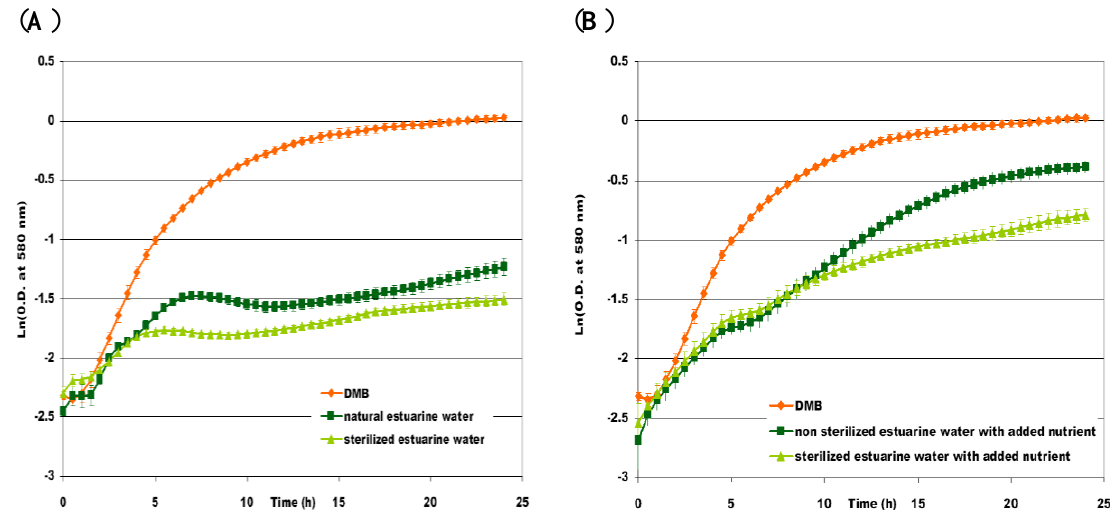
Figure 7. Growth kinetics of P. fluorescens DSS73 ( A ) in sterilized or natural estuarine water; ( B ) in sterilized or unsterilized water supplemented with nutrients, compared to DMB.